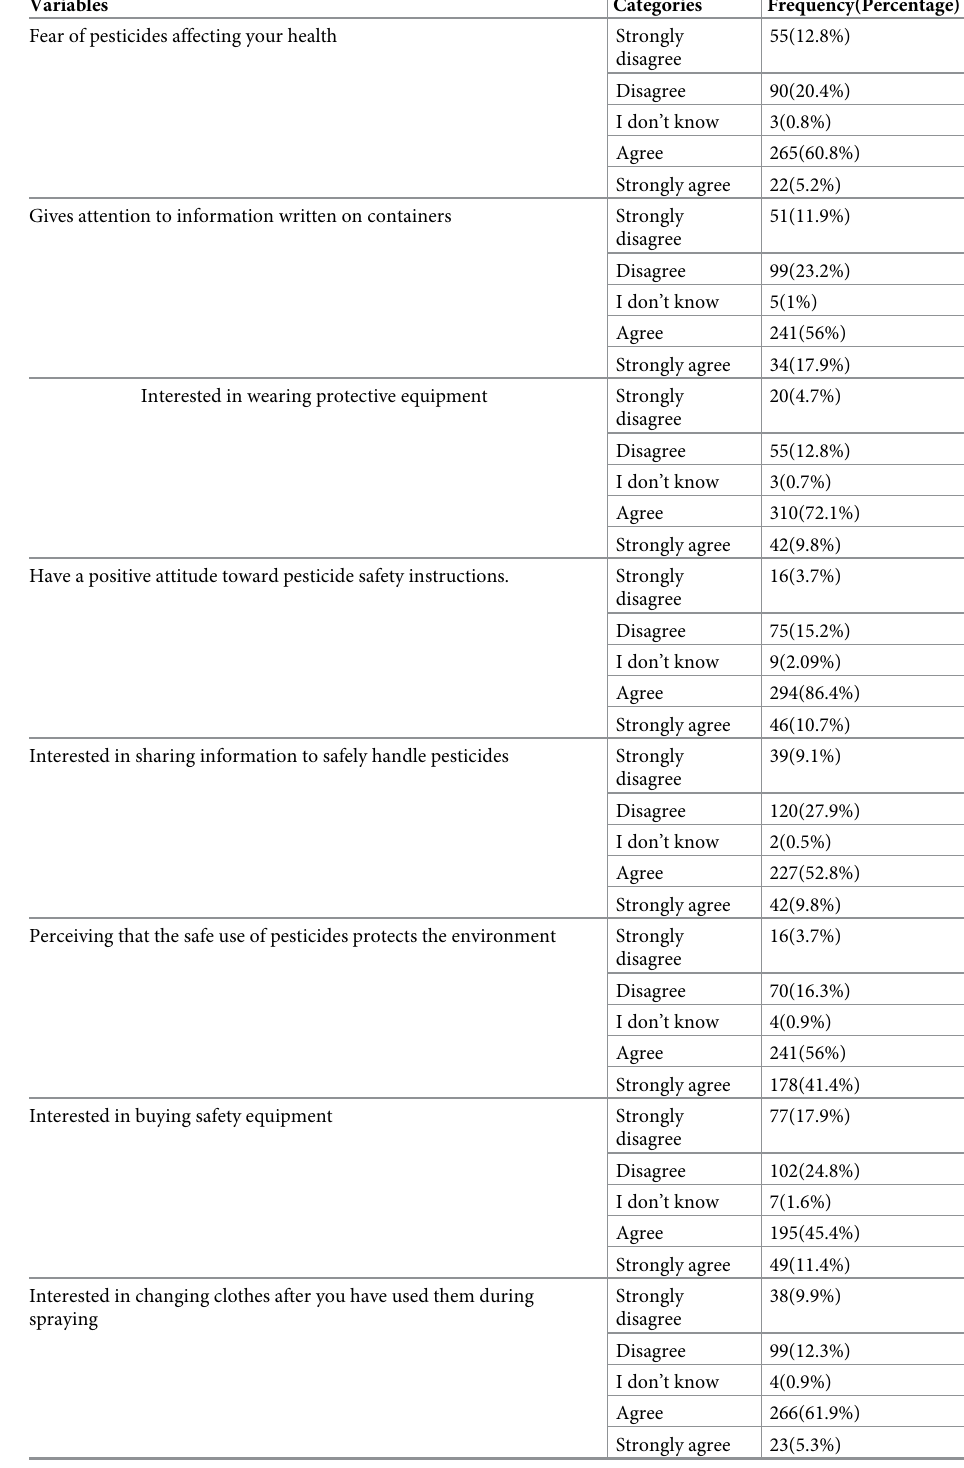
Table 3. Attitudes of farmers on pesticides use safety practice in Fogera district wetland areas, Northwest